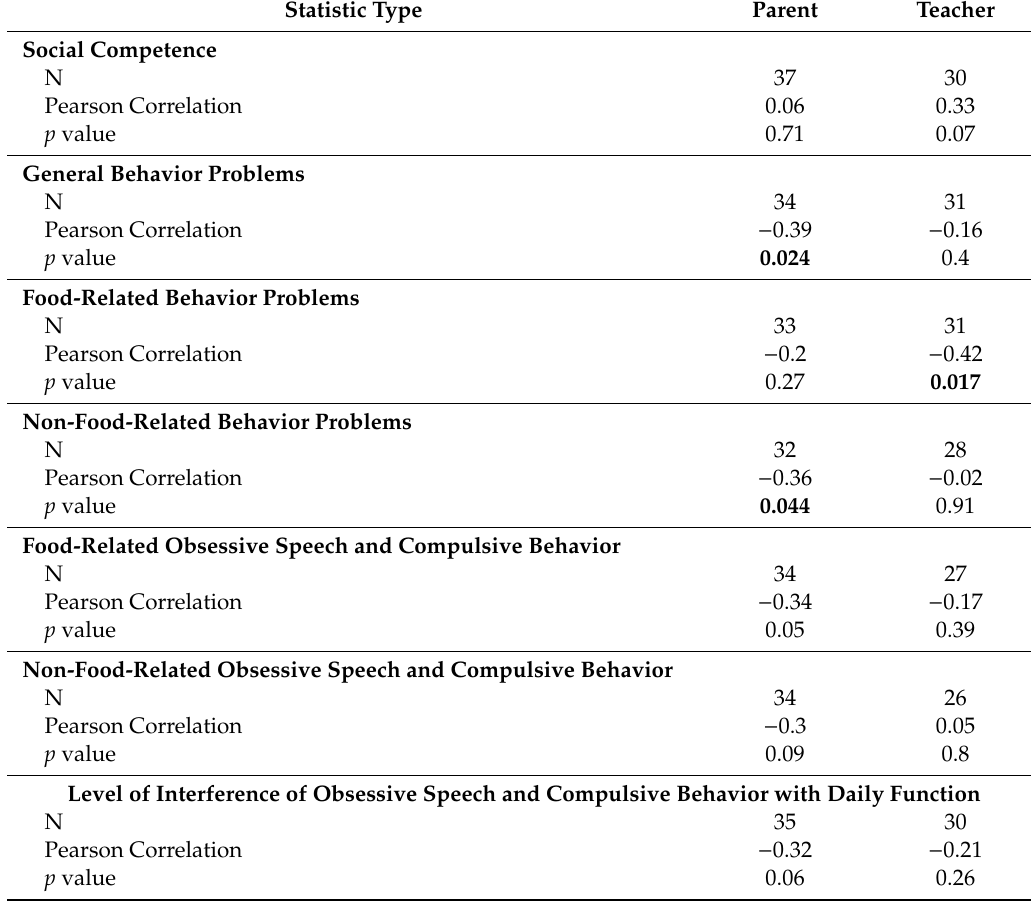
Table 6. Correlation between GAIB Subscales and Stanford–Binet Abbreviated Brief